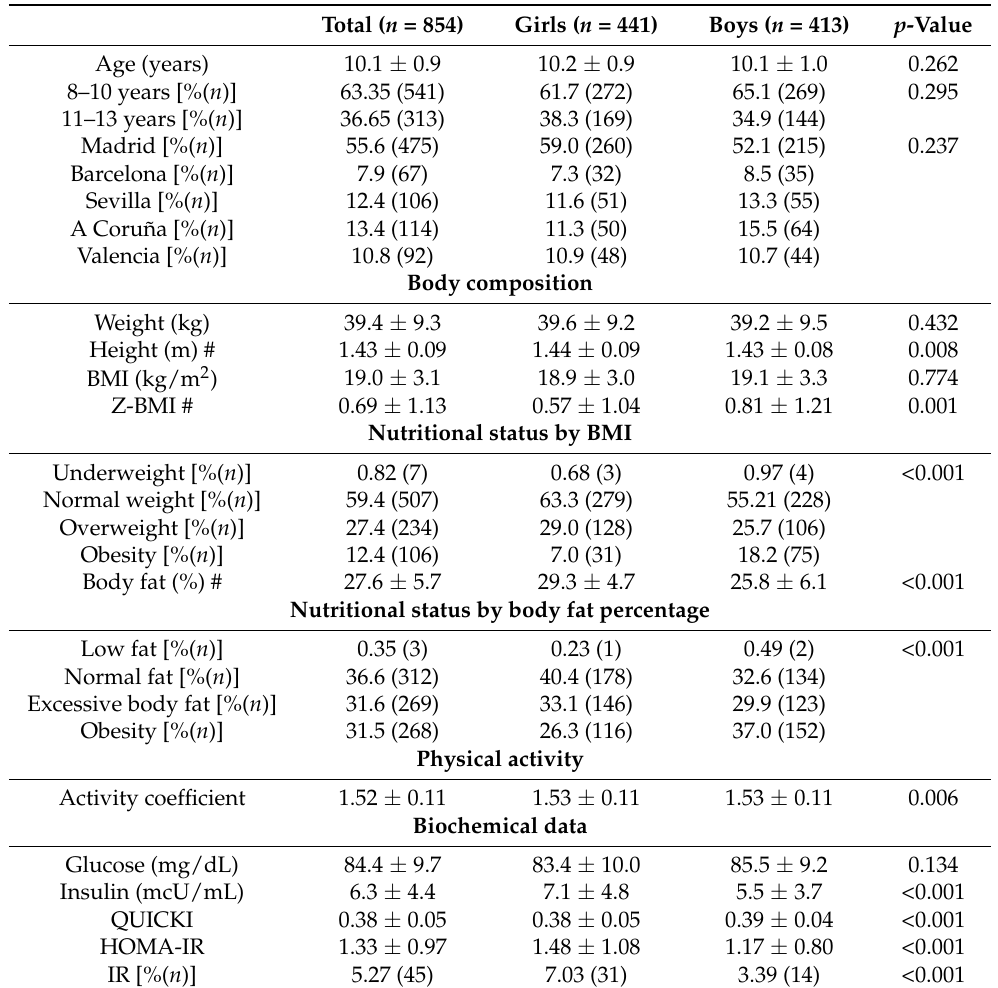
Table 1. Anthropometric, physical activity and blood biochemical parameters in the schoolchildren studied according to